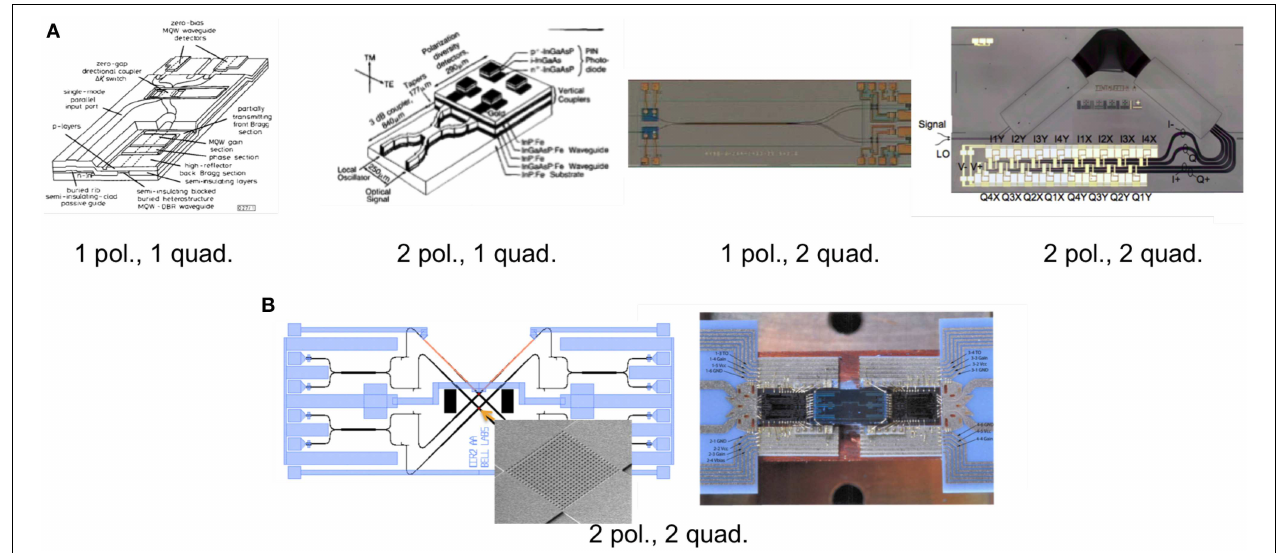
FIGURE 24 | Early (A) InP and (B) silicon integrated coherent receivers.